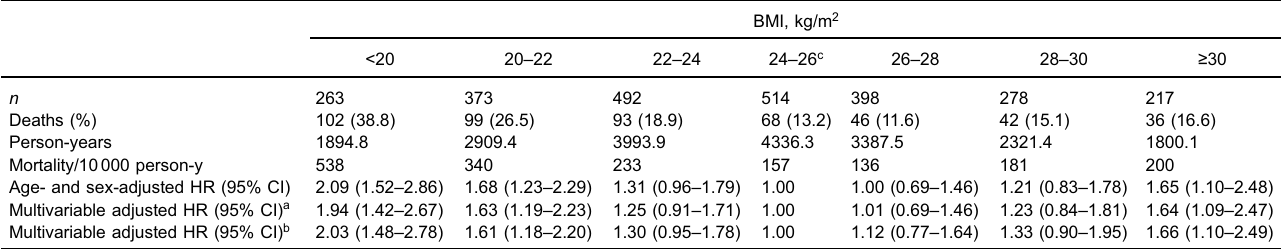
Table 2. Hazard ratio of all-cause mortality according to di ff erent levels of BMI among patients with hypertension